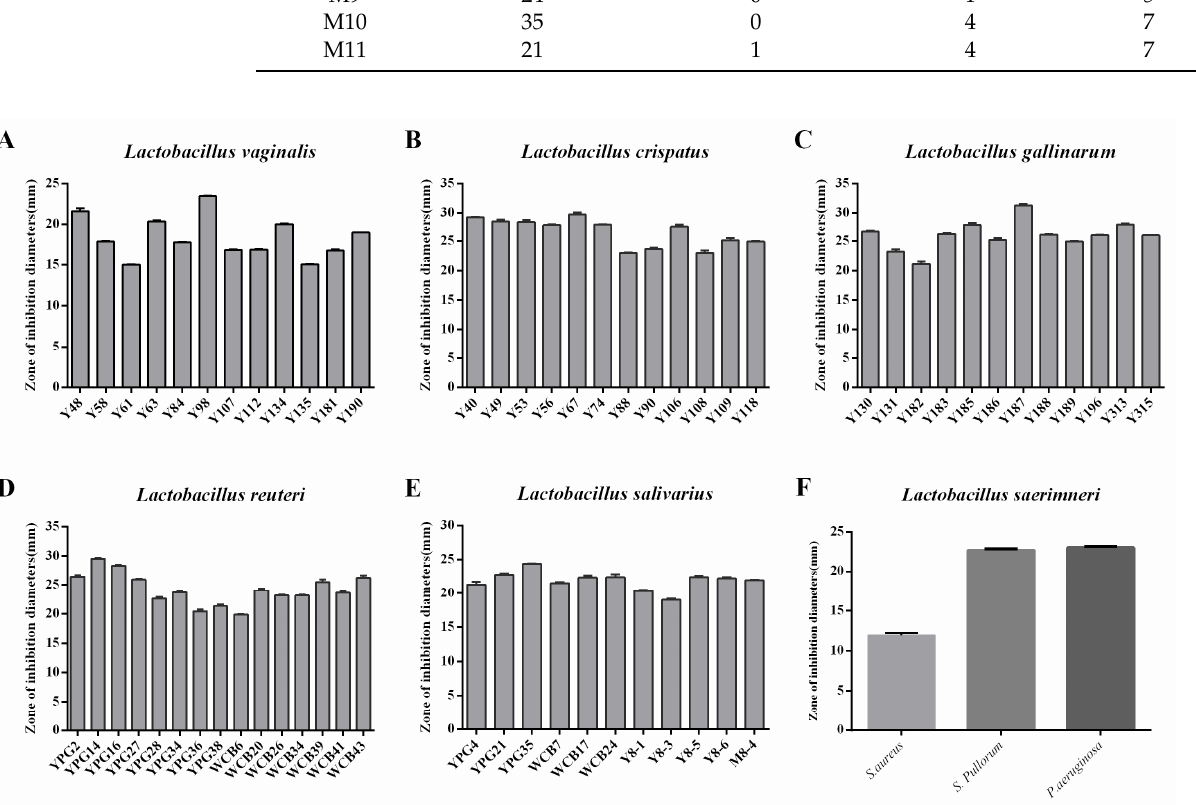
2.2. Selection of Lactobacillus Strains with Antimicrobial Activity against Salmonella Pullorum